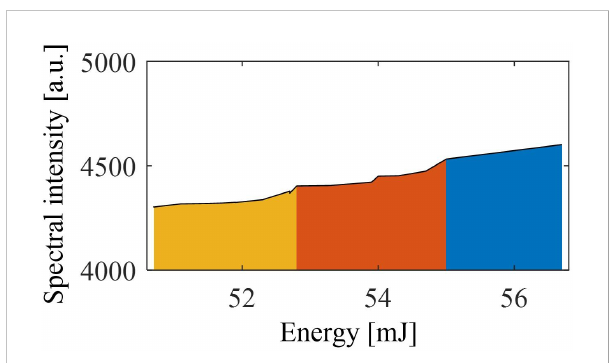
FIGURE 5 The fi gure of relationship between the fl uctuation of laser energy and the change of spectral